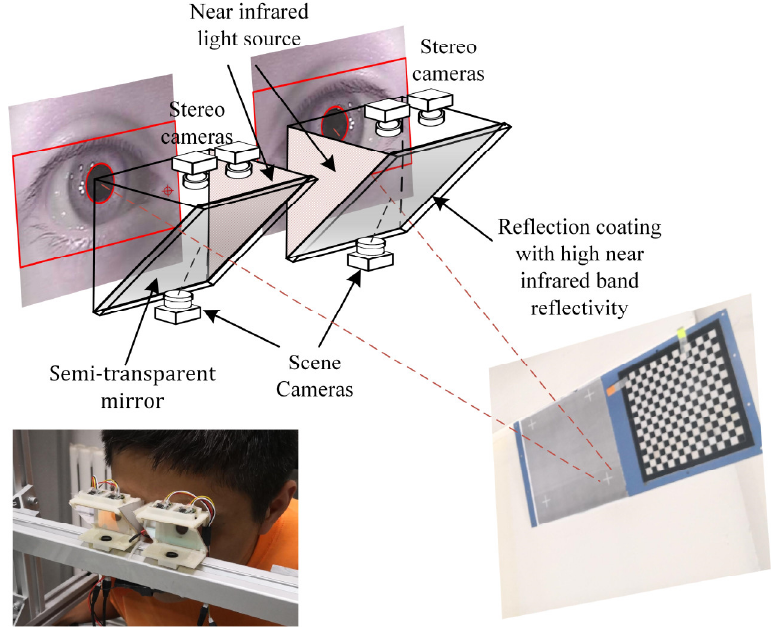
Figure 2. The structure and the photo of the proposed gaze estimation system.